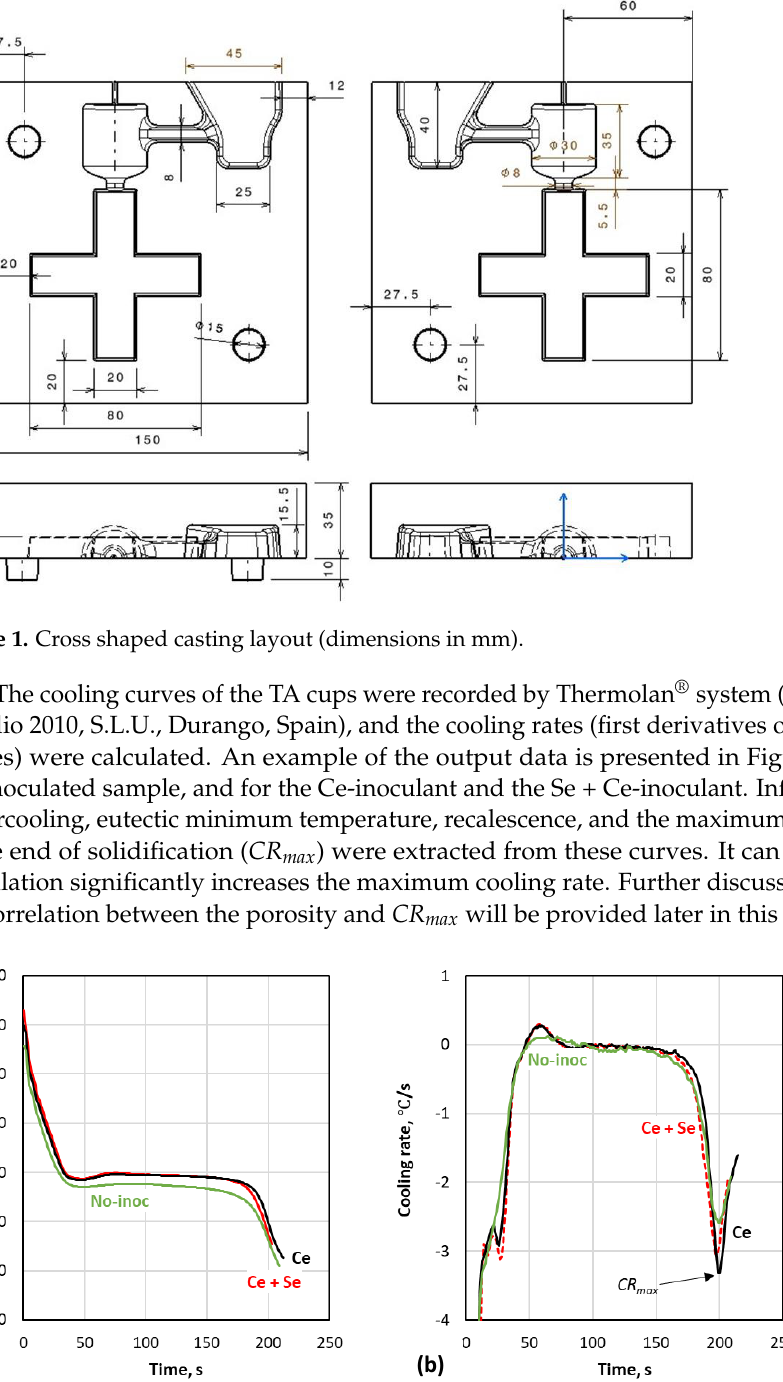
Figure 1. Cross shaped casting layout (dimensions in mm).